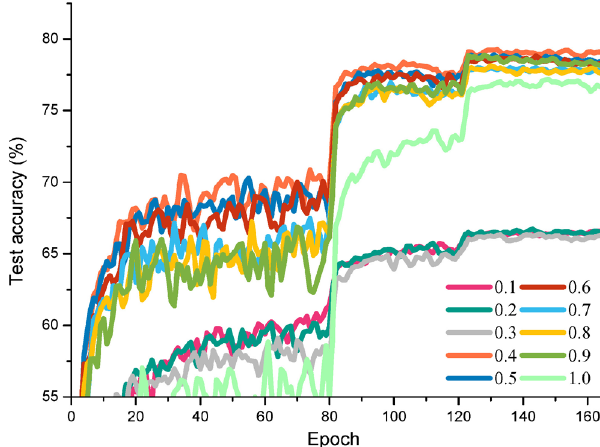
Fig. 6 Influence of hyper-parameter r . High enough async rate always results in improved performance, and the method is not sensitive to the